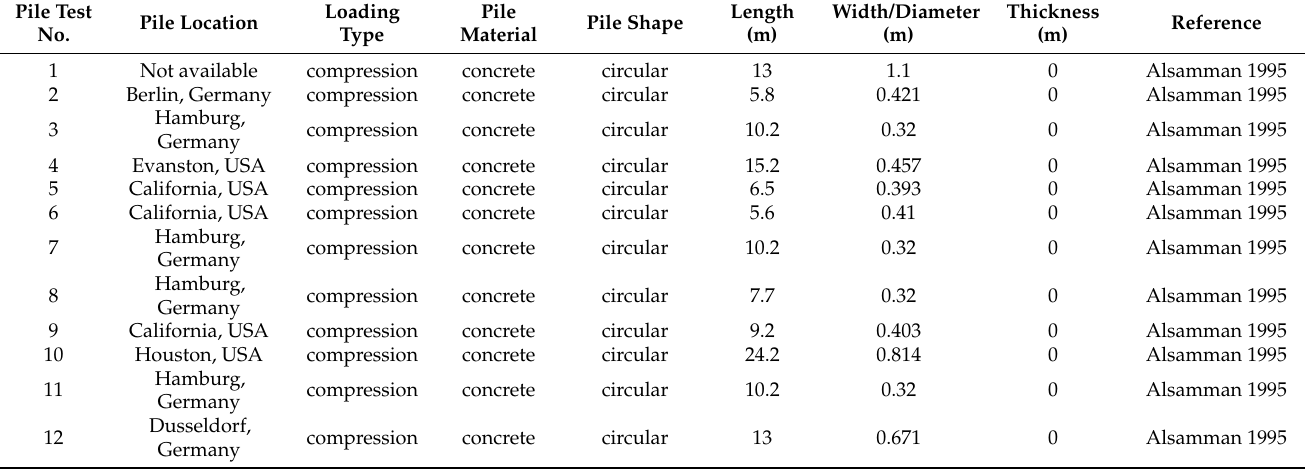
Table A2. Load test locations and pile properties of drilled (bored)